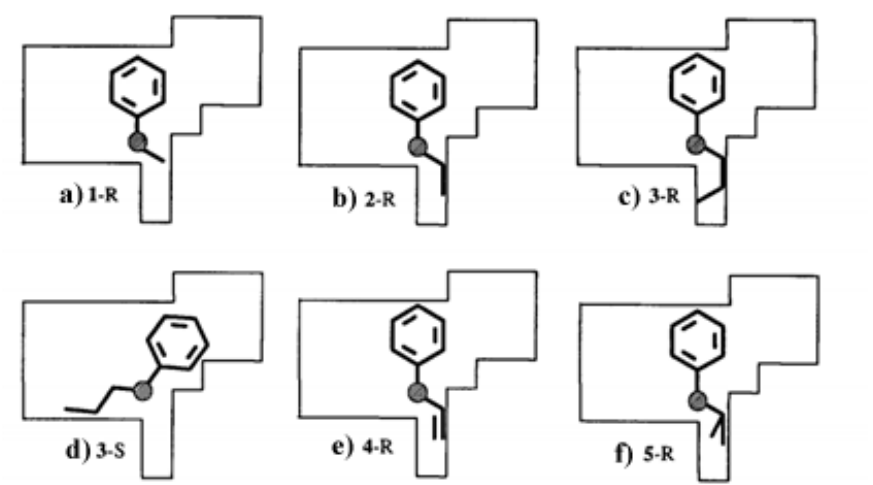
Figure 9 - Top perspective view of the active site model showing the preferred binding modes for phenyl alkyl sulfides. Reprinted with permission from Elsevier (Ottolina et al. 1995). Copyright 2015 Elsevier.